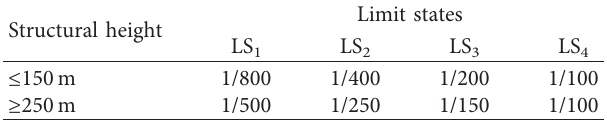
Table 8: Interlayer drift limits of the frame-core tube structure and the hybrid structure.